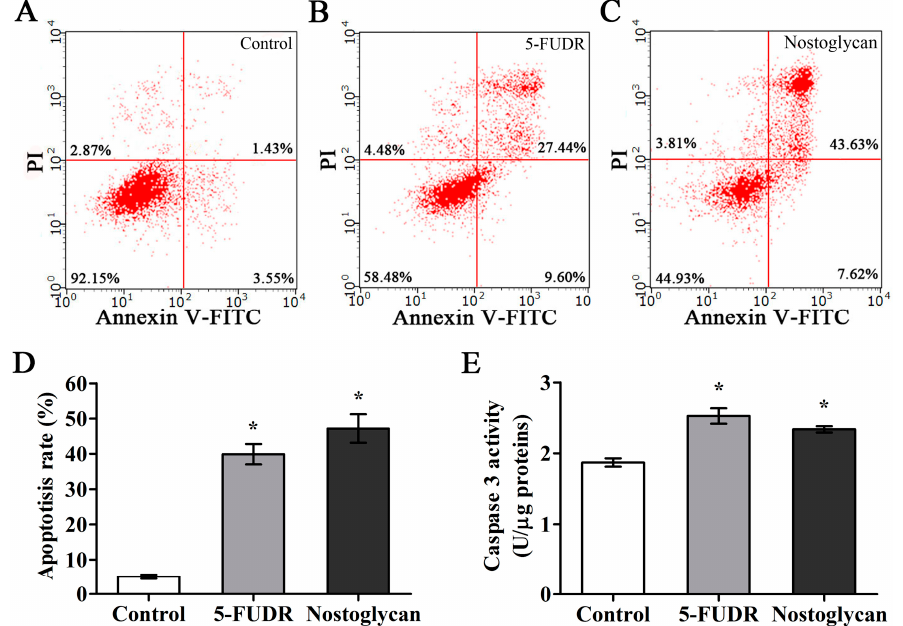
Figure 5. Effect of nostoglycan on apoptosis and caspase-3 activation in tumor cells. Quantitative analysis of apoptosis was performed by flow cytometry using human lung adenocarcinoma cell line A549. The cells were treated with medium (control; A ), 100 μ g/mL 5-FUDR ( B ) or 1.0 mg/mL nostoglycan ( C ) for 48 h and then subjected to Annexin V-FITC/PI staining and flow cytometry analysis. Apoptosis rate was calculated as the percentage of Annexin V-positive cells in >10,000 total cells ( D ). The activity of caspase-3 in A549 cells was determined by colorimetric assay ( E ). Data are presented as mean ± SEM of three independent experiments. * p < 0.05.